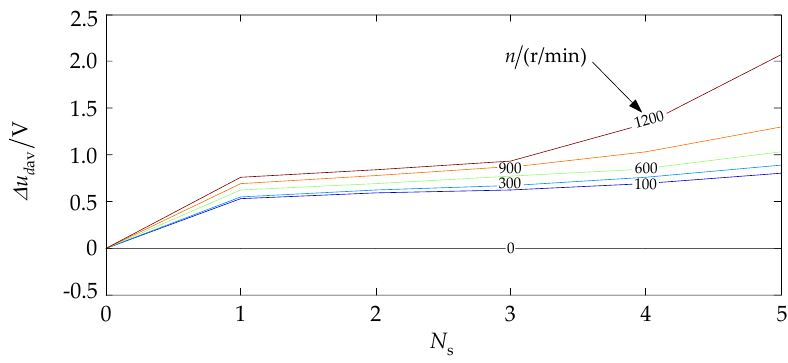
Figure 24. The variation curves of ∆ u d av with the speed and the number of short-circuited turns. It can be obtained from Figure 24 that when an ISCF occurs, ∆ u d av change above 0.5 V under